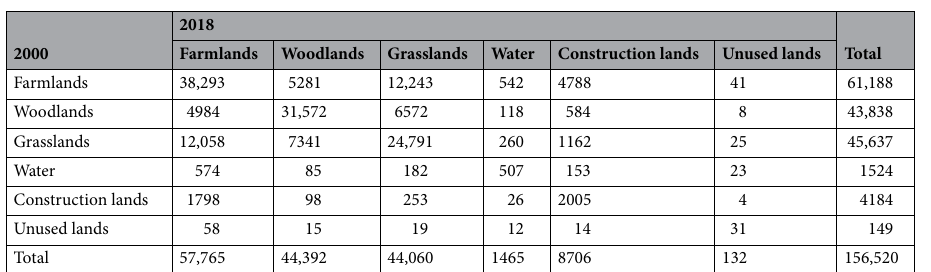
Table 3. LULCC in Shanxi Province between 2000 and 2018 (units: km 2